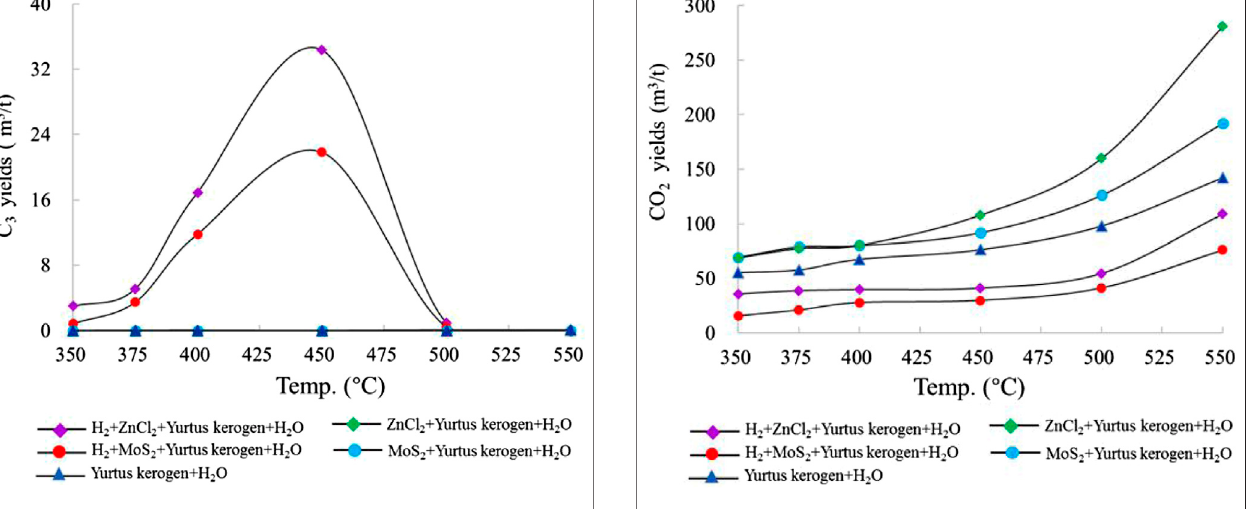
FIGURE 4 | Change in CO 2 yield simulated under different catalytic hydrogenation control conditions of the closed